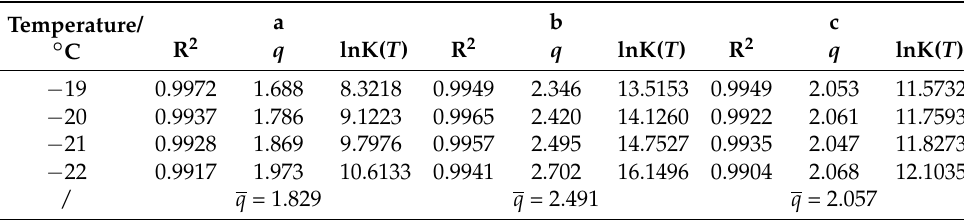
a b Temperature/ ◦ C